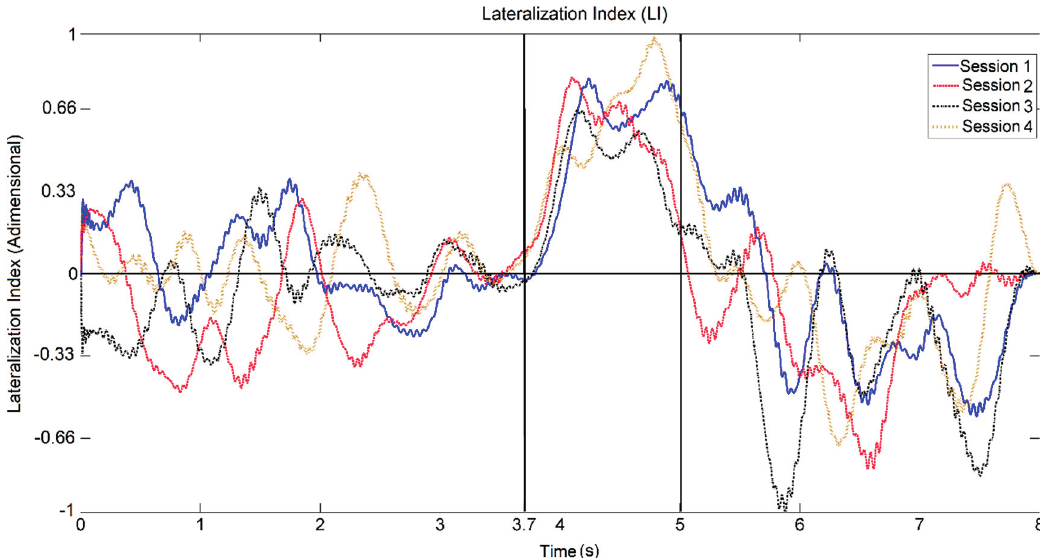
Figure 7. Relative average LI for channels C3, C4, P3 and P4 in all sessions.